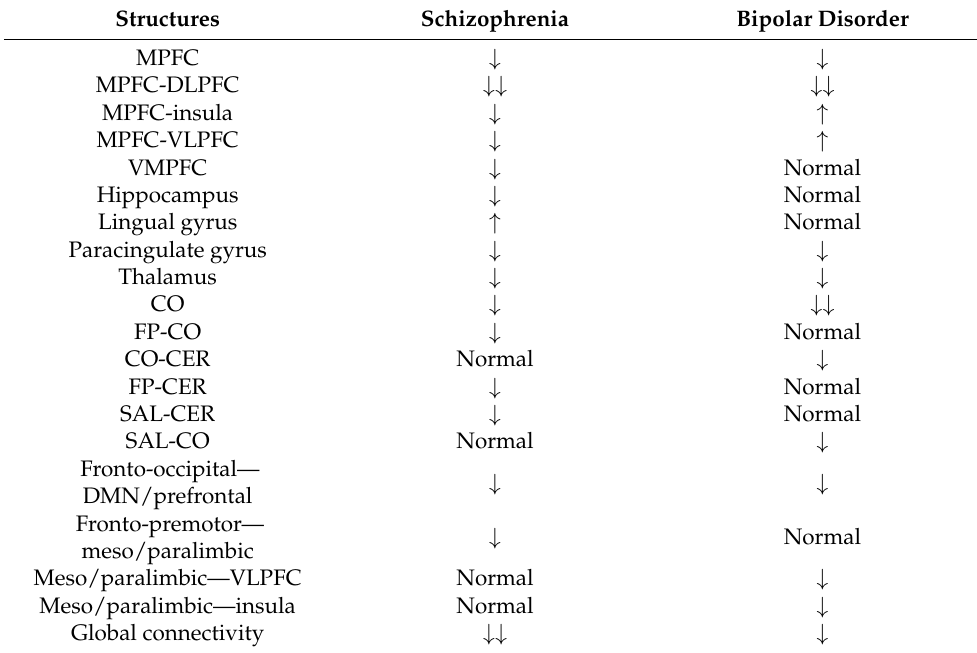
Table 3. Functional abnormalities in schizophrenia and bipolar